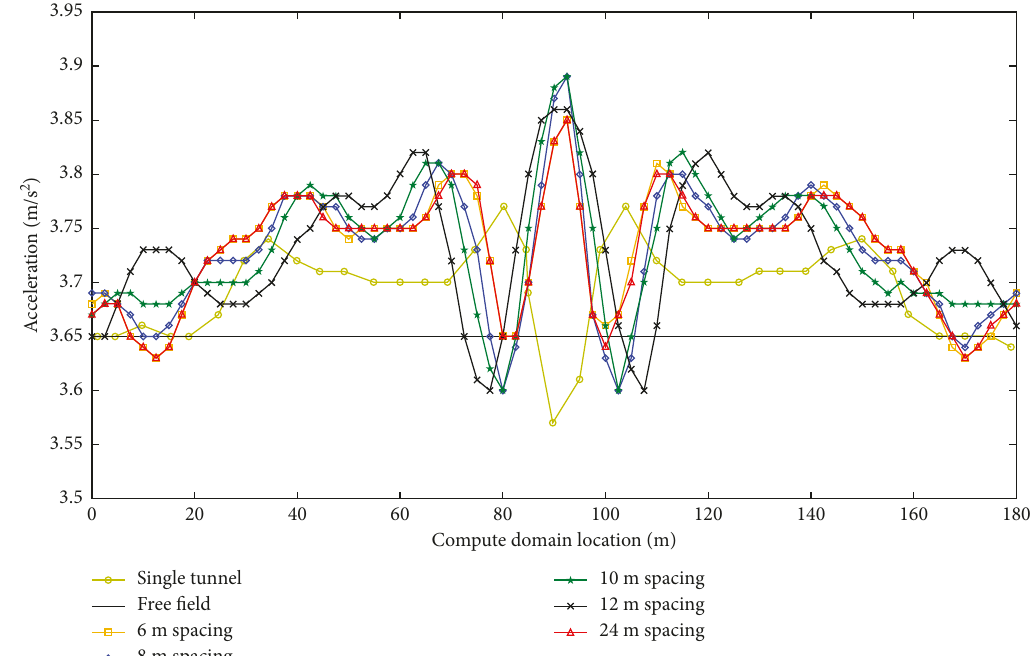
Figure 11: Comparison of peak ground